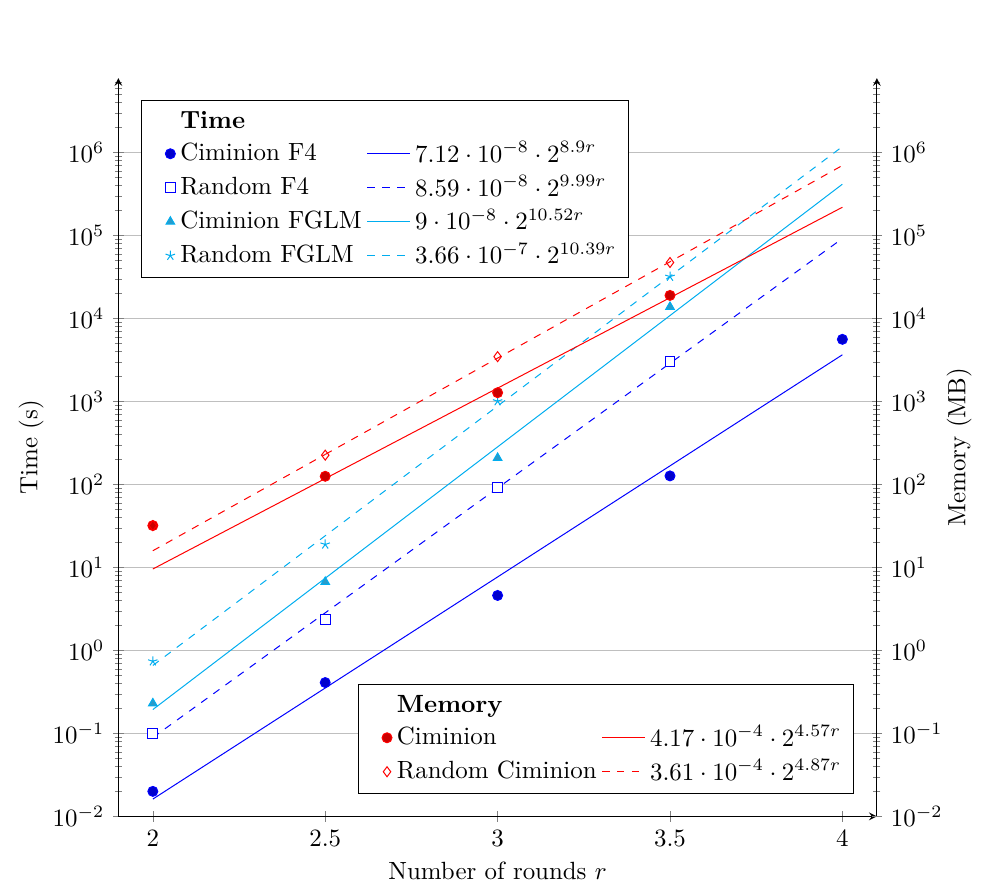
Figure 14: Benchmarks of multivariate root finding with Magma using 1 CPU core of an Intel Xeon Gold 5218, for Ciminion and Ciminion-like systems (4 equations of high